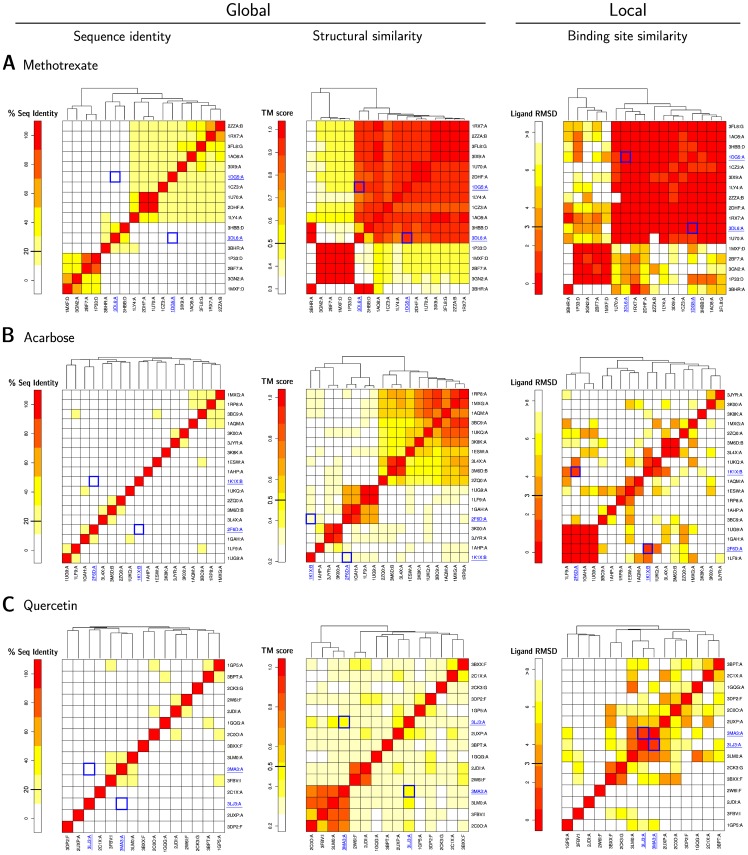
Target similarity.The heatmaps for the targets of methotrexate (A), acarbose (B) and quercetin (C) show that the target sequences are dissimilar (left), the global structural similarity (middle) is comparable to the sequence identity and the binding sites are overall more similar (right). (A) Two DHFR (1dg5, 3dl6) with a conserved 3D structure and similar binding sites for methotrexate are highlighted. (B) Although the proteins 4--glucanotransferase (1k1x) and glucoamylase (2f6d) have globally distinct sequences and structures, they bind acarbose in a very similar way. (C) The two protein kinases PI3KCG (3lj3) and PIM1 (3ma3) share a similar binding pocket for quercetin.